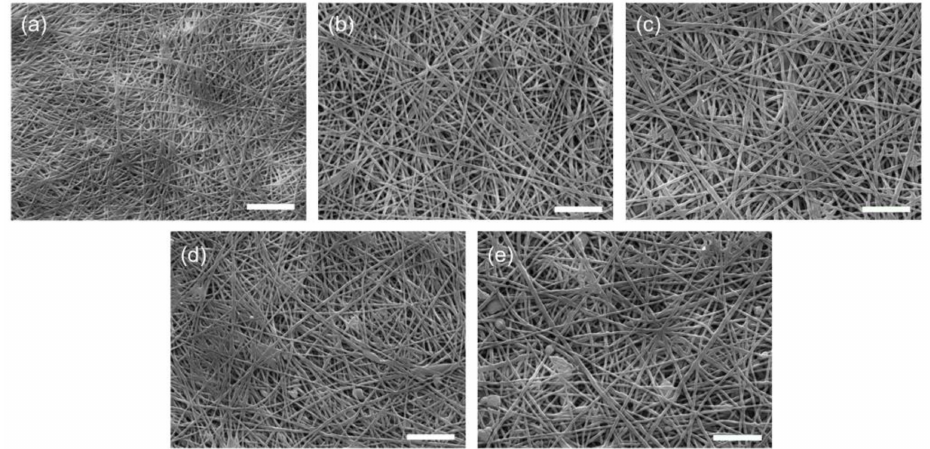
Figure 1. Surface SEM images of the PAN/ADEP composite membranes after sputter coating with platinum under a vacuum for 2 min: ( a ) PAN; ( b ) PAN/AD5; ( c ) PAN/AD10; ( d ) PAN/AD15; ( e ) PAN/AD20. The scale bars represent 10 µ m.